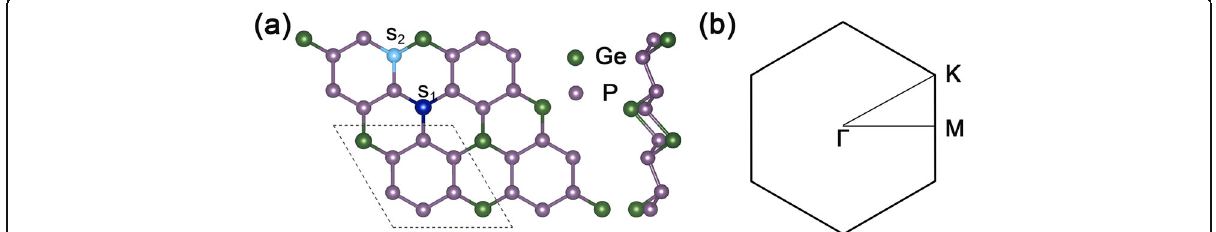
Fig. 1 Geometrical structure and Brillouin zone of GeP 3 . a Top and side views of the optimized geometry of GeP 3 with a 2×2 supercell. The dotted line presents the unit cell of GeP 3 monolayer, S 1 represents the site of substituting position of Ge site, and S 2 represents the site of substituting position P atom. b the 2D Brillouin zone of GeP 3